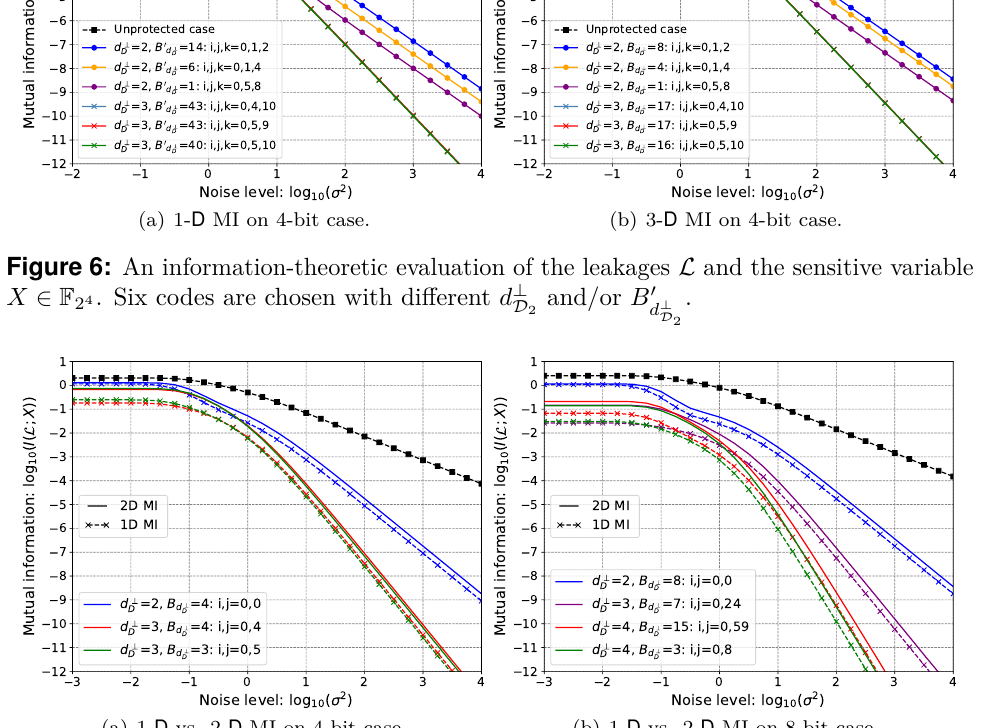
Figure 7: Comparing 1- D and 2- D MI on different linear codes where the sum and joint distribution are used to combine the bivariate leakages, respectively. Note that the blue curves are for the Boolean